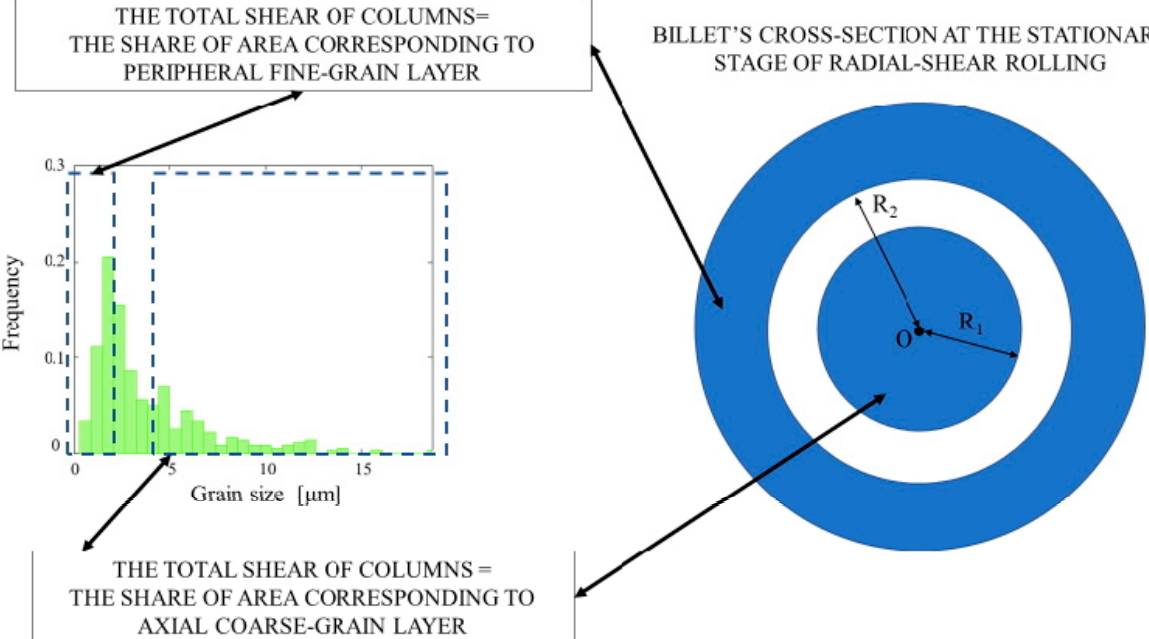
Figure 9. Detection of the borders of the region, which contains the neutral cylindrical layer based on the β -phase grain size distribution histogram analysis (O—center of the circle, which is the cross section of the billet at the stationary stage of the radial shear rolling, R 1 , R 2 —radii limiting the neutral layer).